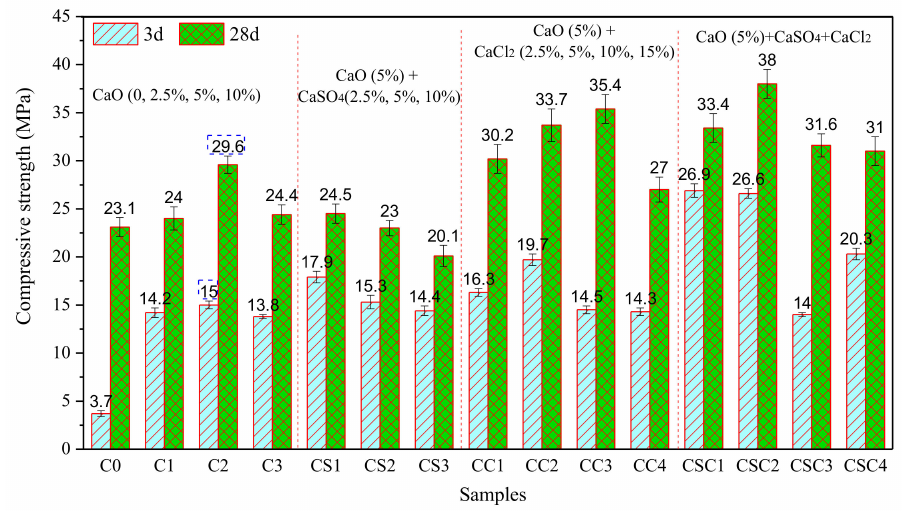
Figure 4. Compressive strength of SR-activated GGBFS mortars with different